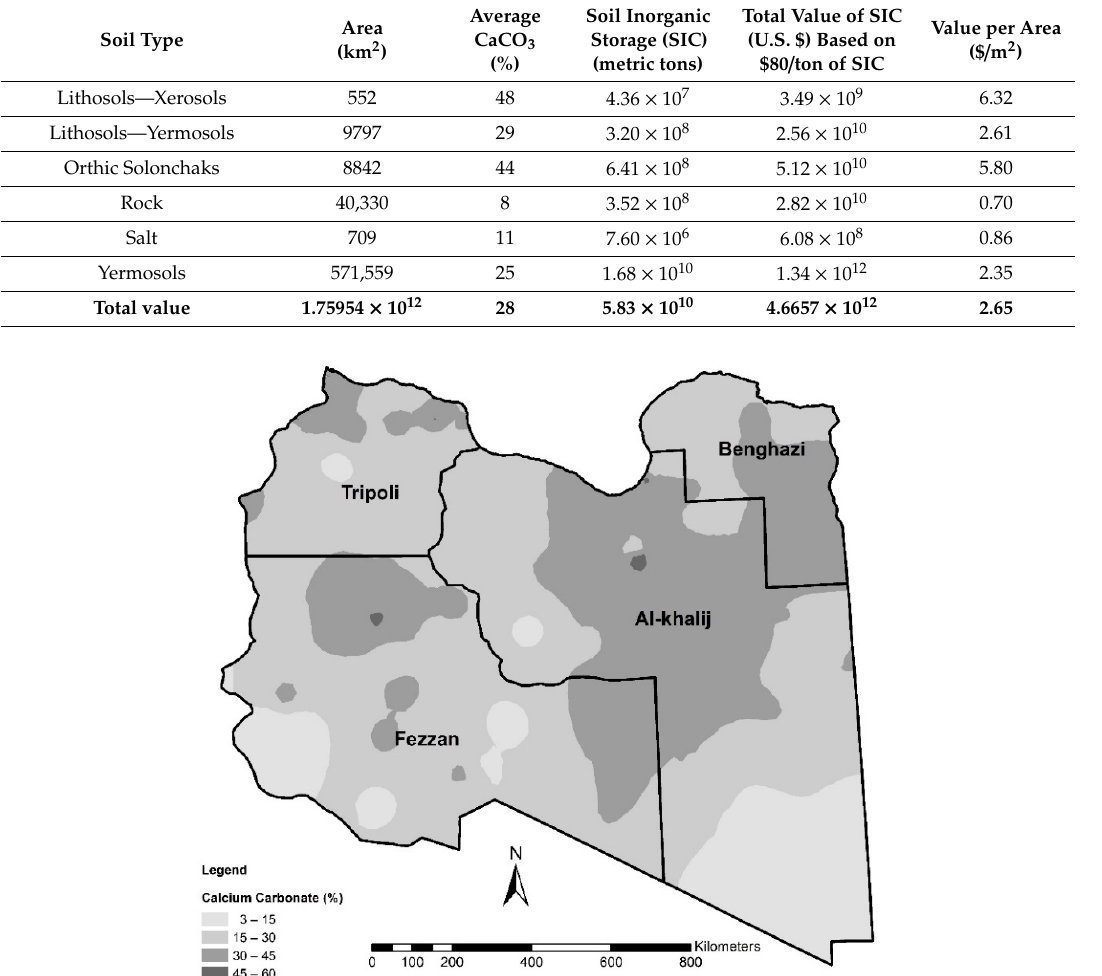
Figure 6. Calcium carbonate distribution in Libyan soils.